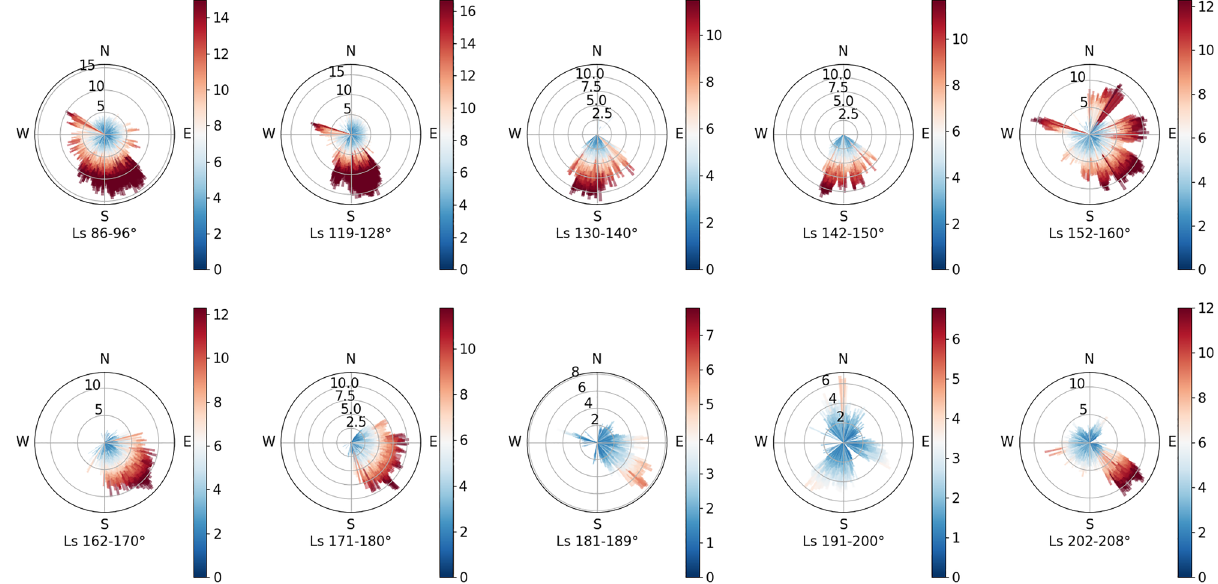
Figure 7. Wind speed and direction monitored by MCS during the mission time of 325 sols. Winds are analyzed by about every 10° during Ls = 152° to Ls = 160°, the wind direction becomes southeastwards until the northern fall equinox. After that, the wind becomes slightly weak while at the end of the mission time, the wind speed becomes stronger again and turns southeast. We find that the strongest wind recorded by Tianwen-1’s wind sensors appears in the range of Ls = 119–128°. The maximum wind speed is 16.7 m/s. According to data recorded by the digital elevation model near the